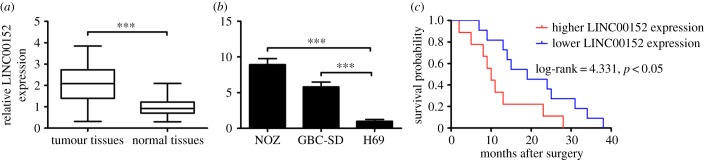
LINC00152 is overexpressed in GBC tissue samples. (a) LINC00152 expression levels in GBC and adjacent normal tissue samples were detected by qPCR (n = 35). The relative expression fold change of mRNAs was calculated by the 2−△△Ct method. The expression of LINC00152 was normalized to ACTIN. The statistical differences between samples were analysed with paired-samples t-test. (b) LINC00152 expression levels in GBC cell lines NOZ and GBC-SD were detected by qPCR and compared with those in the human gallbladder epithelium cell line H69. The expression of LINC00152 was normalized to that in H69. (c) LINC00152 correlates negatively with overall survival time (log-rank = 4.331, p < 0.05). The mean ± s.d. of triplicate experiments were plotted, ***p < 0.001.